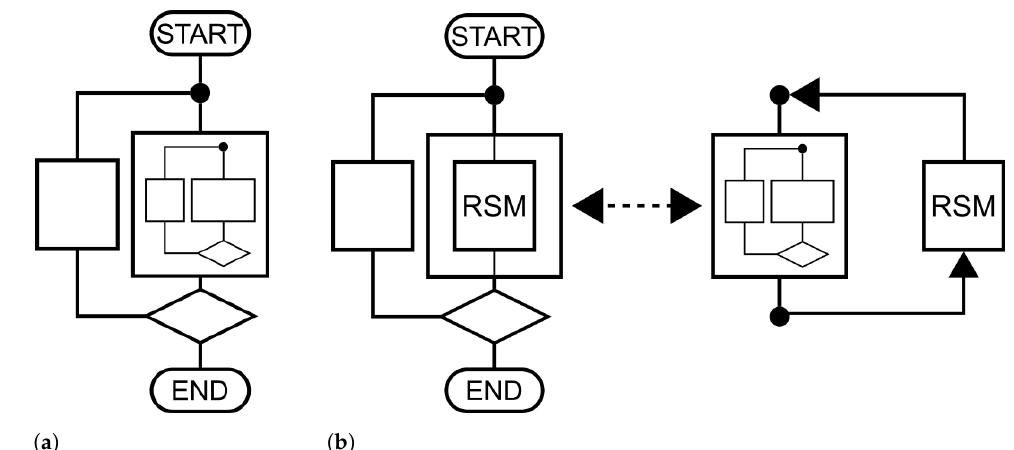
Figure 12. A response surface can be used to decouple a two-level architecture. ( a ) Two-level architecture, with a nested optimisation loop. ( b ) A response surface (RSM) can be substituted for the nested procedure. The RSM can be created and updated in parallel, effectively decoupling the two optimisation